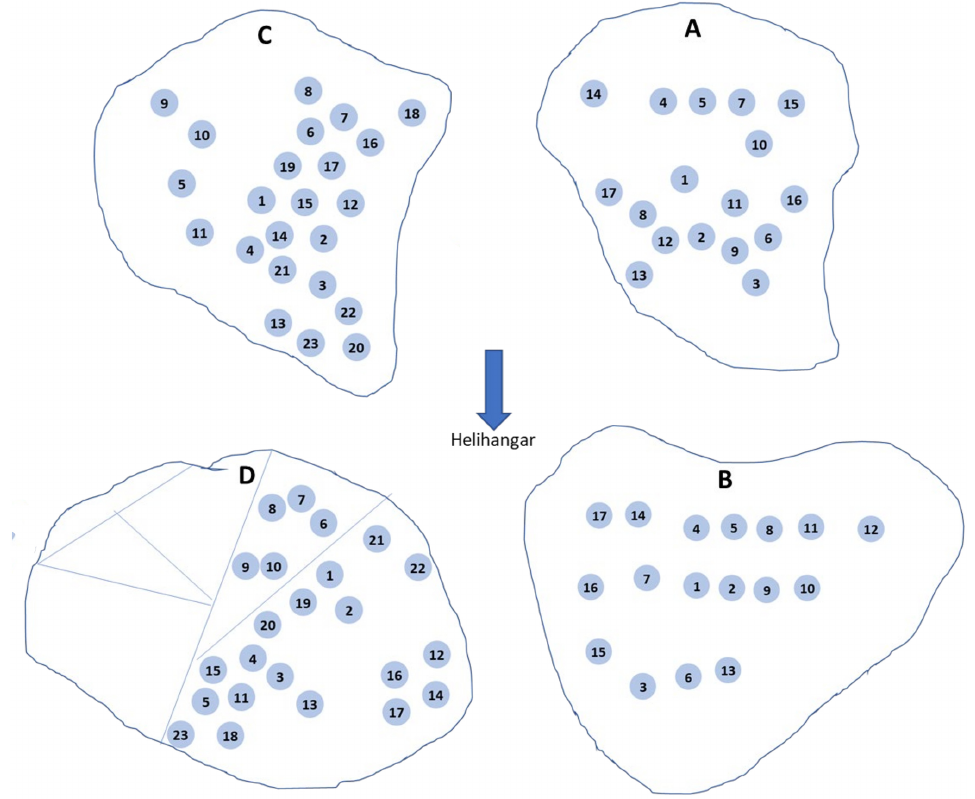
Figure A1. Coring layout for pancake ice floes A, B, C and D.